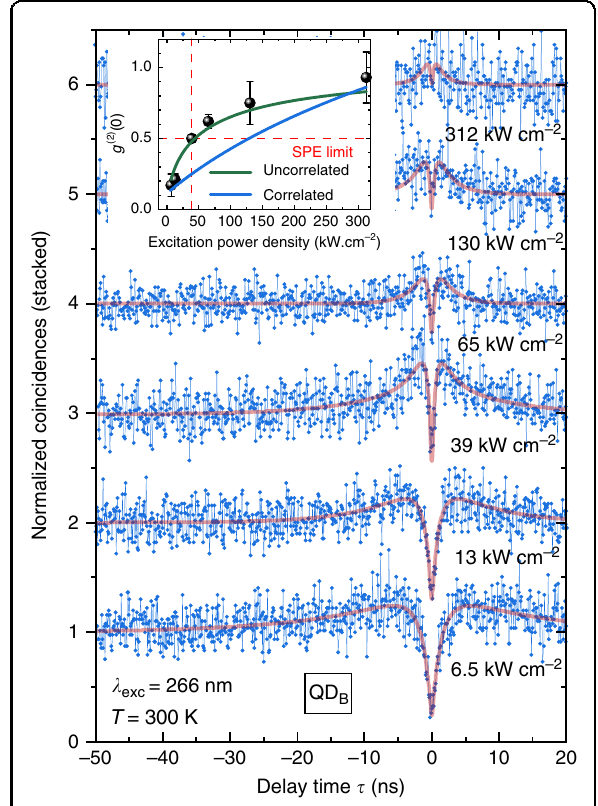
Fig. 4 g (2) ( τ ) traces of QD A recorded at an excitation power density of 400 kW cm − 2 as a function of temperature, with a channel resolution of 100 ps/channel (connected blue diamonds) and convoluted fi ts (red lines). All uncertainties are obtained in the simpli fi ed framework described in the text and only indicate the fi tting robustness. The full collected data span a range of ±130 ns around 0. The inset in the top panel is a zoomed-in view of the antibunching dip